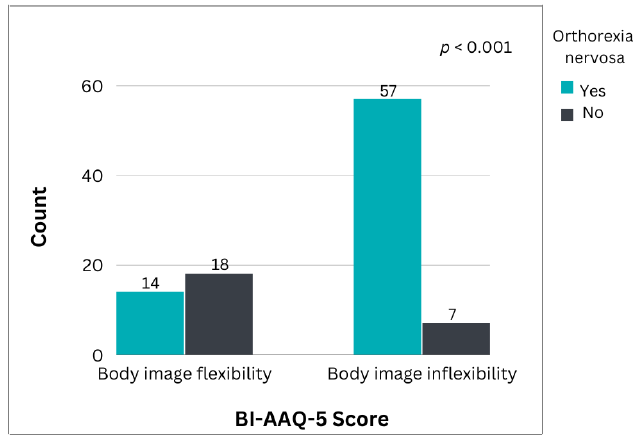
Figure 1. Correlation between orthorexia nervosa (ON) evaluated with the ORTHO-15 question- naire, and body image inflexibility according to the BI-AAQ-5 score in professional dancers ( n = 96; p < 0.001).